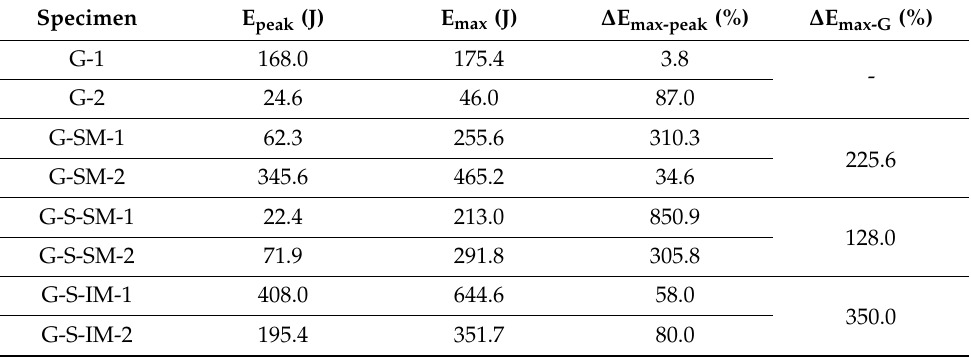
Table 3. Cumulative external energy before and after reaching the maximum load. Relative increment respect to the energy at peak load. Average energy relative increase respect to G